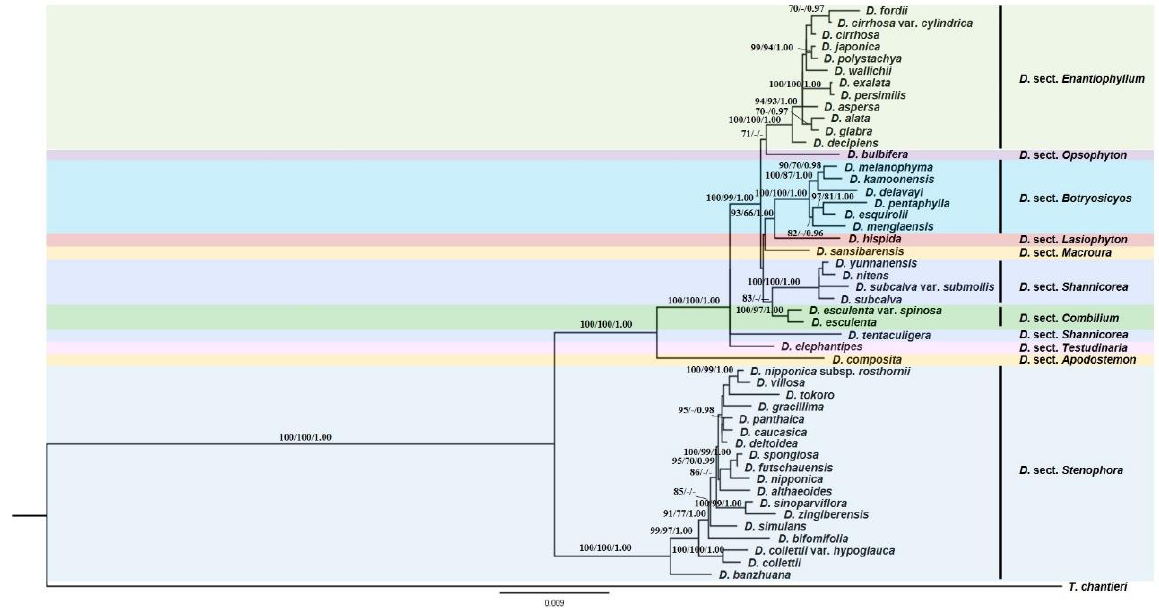
Figure 2. The maximum likelihood tree using the combined data from chloroplast mat K, rbc L, trn L-